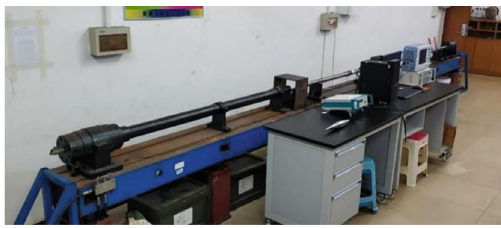
Figure 3: Split Hopkinson Pressure Bar test device